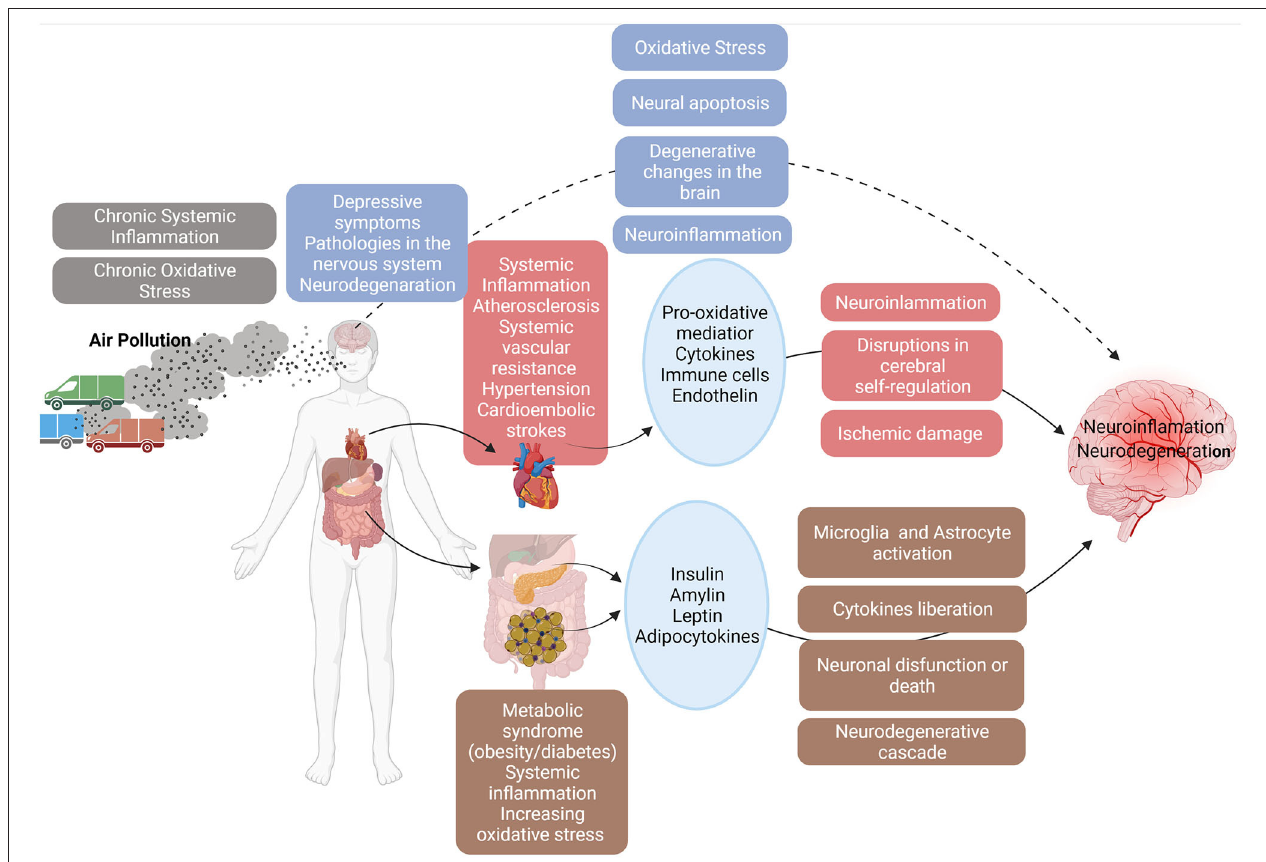
FIGURE 1 | The toxicity mechanisms: air pollution acts directly in brain and indirectly in cardiovascular diseases and metabolic syndromes causing neuroinflammation and neurodegeneration. Created with BioRender.com.